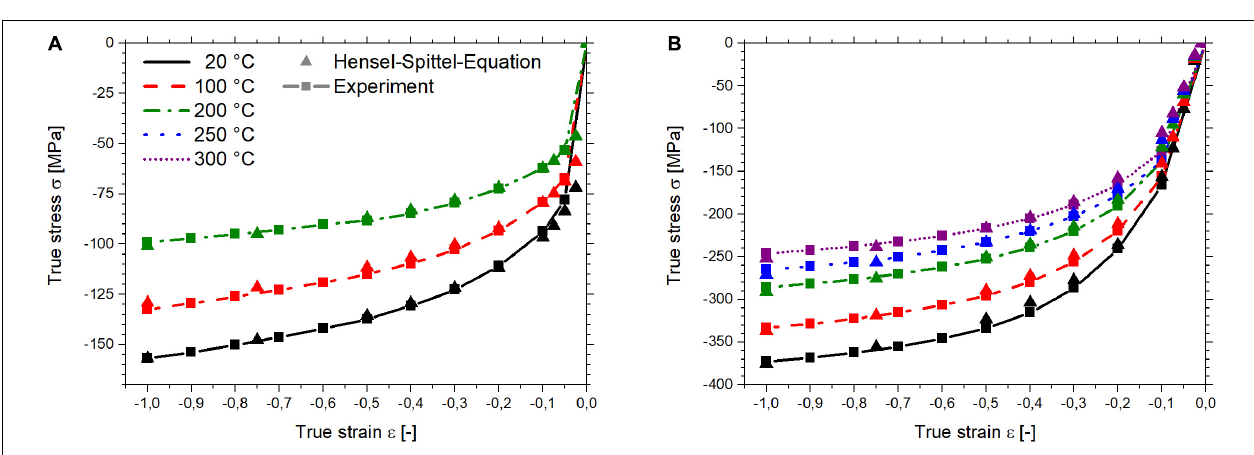
FIGURE 6 | Comparison of the experimental flow curves and the data approximated with the Hensel–Spittel-equation at a strain rate of ˙ ε = 1 s − 1 : (A) extruded EN AW-1080A, (B)